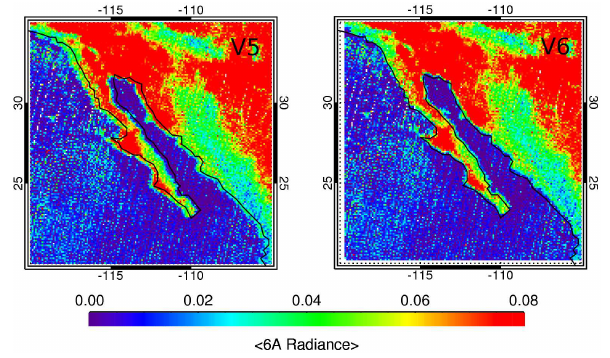
Figure 1. Gridded Channel 6 “Average” (6A) NIR radiances for daytime MOPITT overpasses of Baja California during 2002. NIR radiances are generally larger over land than over ocean because of higher albedo. V5 radiances in the left panel clearly exhibit a lateral shift (or geolocation bias) between the true coastline and the coastline indicated by the radiances. This bias is greatly reduced in the V6 radiances presented in the right